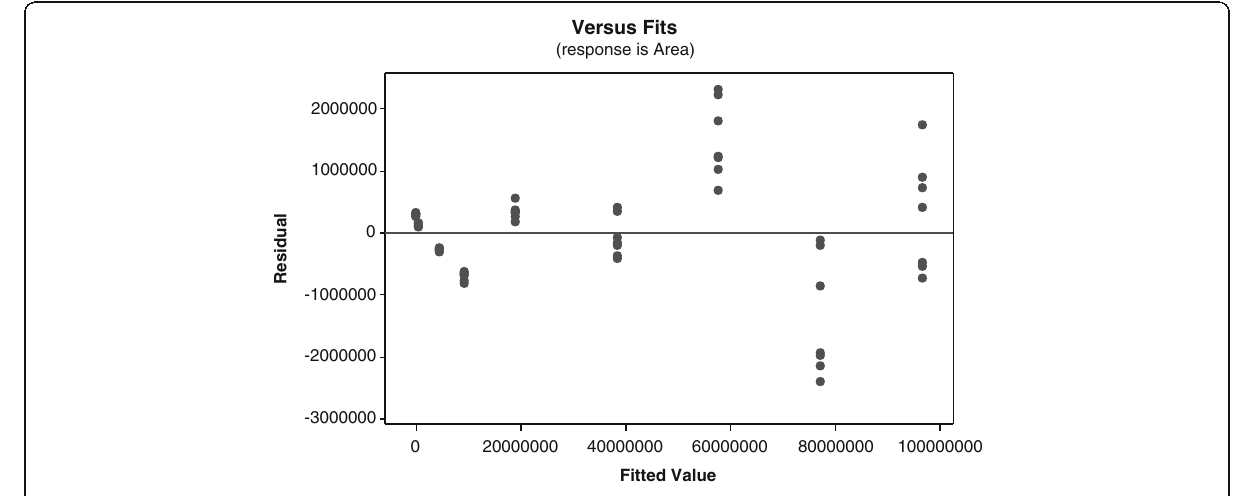
Fig. 3 Residual plot with acceptable level of randomness in